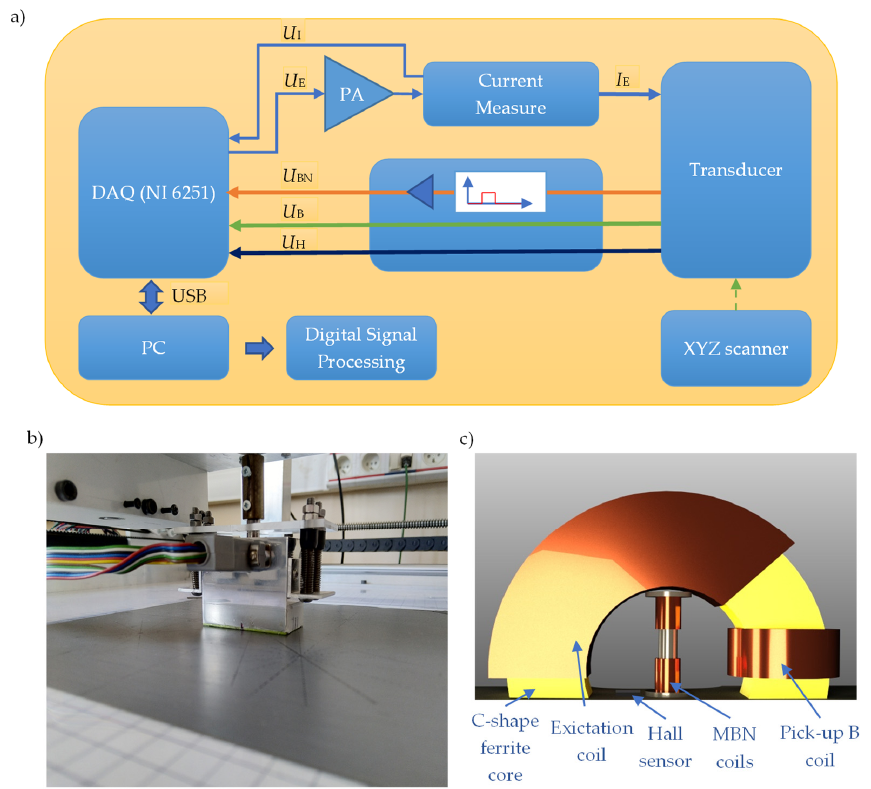
Figure 2. The measurement system and XYZ scanner with mounted transducer: ( a ) schematic view of the configuration, ( b ) photo and ( c ) 3D view of the transducer.